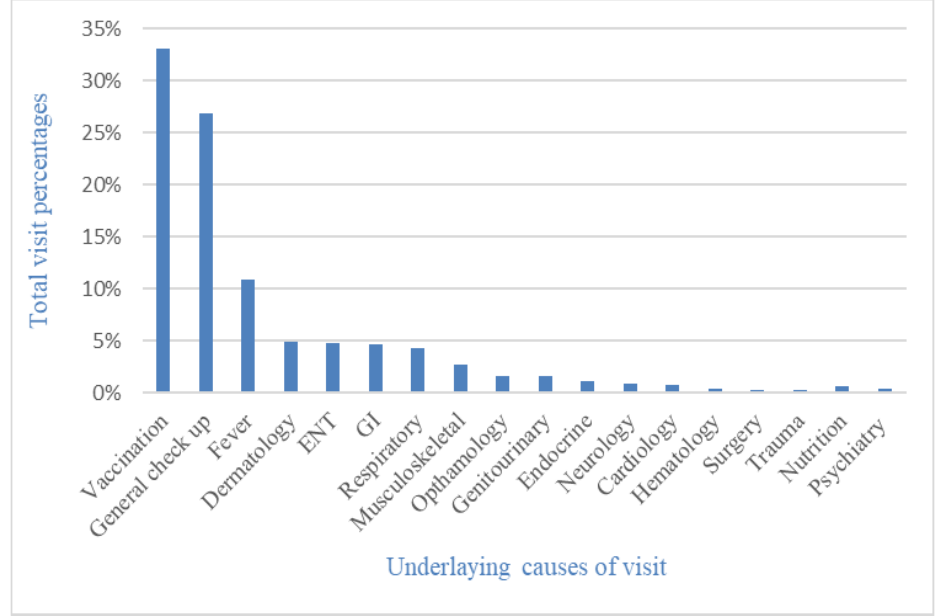
Figure 1. Percentages of systems involved in main complaints of pediatric visits. ENT, ear nose and throat; GI, gastrointestinal. Table 2. Systems involved in main complaints of pediatric visits to PHC according to